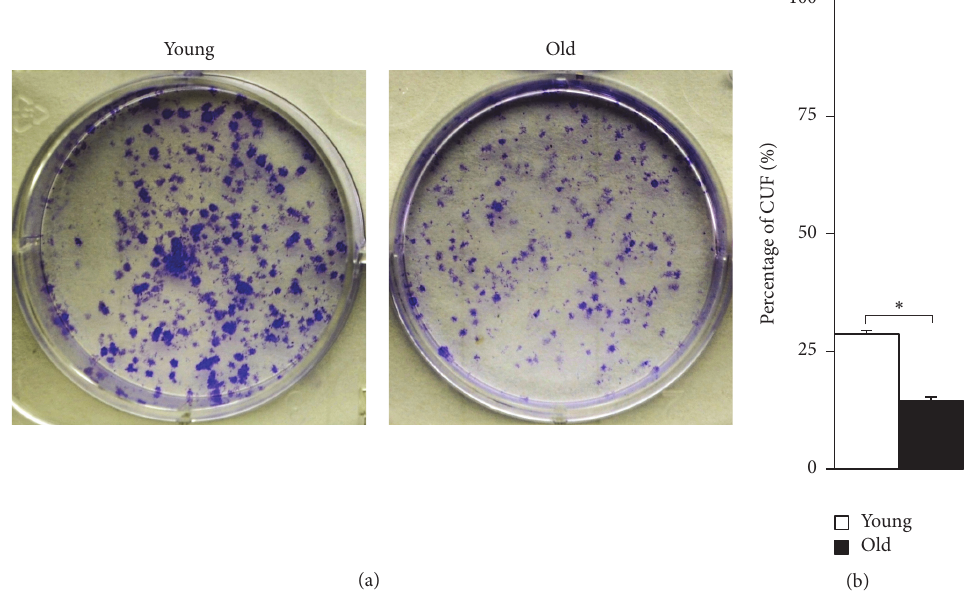
Figure 4: Colony-forming of NPMSCs ( 𝑛 = 5 ). (a) Representative images of Crystal Violet staining of colonies formed in young and old NPMSCs after incubation for 14 days. The colony-forming units (CFUs) formed in young NPMSCs were larger and more numerous than in old NPMSCs. (b) Quantitative analysis also showed that old NPMSCs displayed a significantly lower colony-forming efficiency than young NPMSCs, indicating a better colony-forming ability in young NPMSCs. The data are expressed as means ± SD. ∗ indicates 𝑃 < 0.05